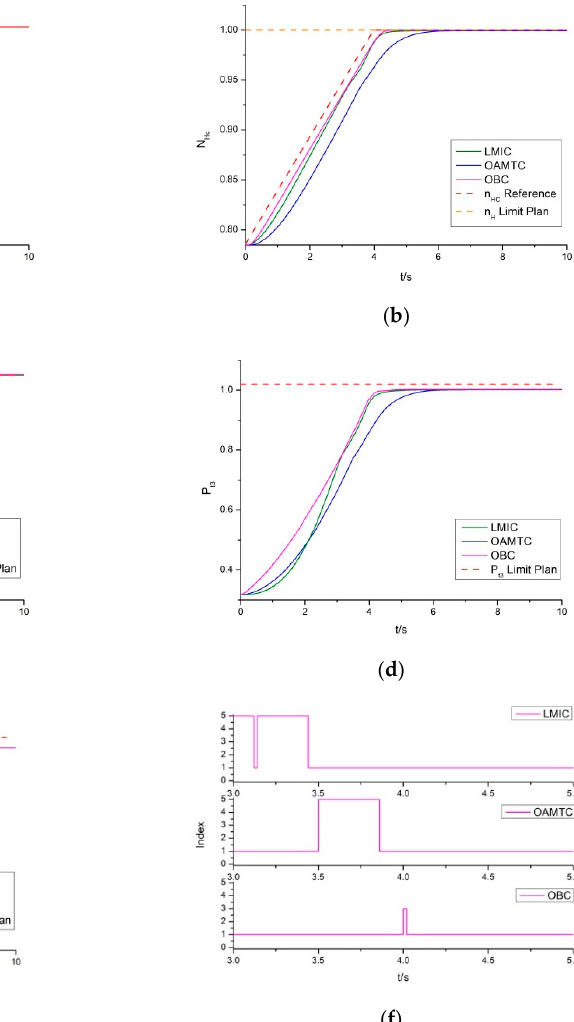
Figure 16. Simulation results of the acceleration limit management control under the ground condition: ( a ) PLA; ( b ) Corrected high-pressure rotor speed response; ( c ) Low-pressure rotor speed response; ( d ) High-pressure compressor outlet total pressure response; ( e ) Mixing chamber inlet total temperature response; ( f ) Controller index.